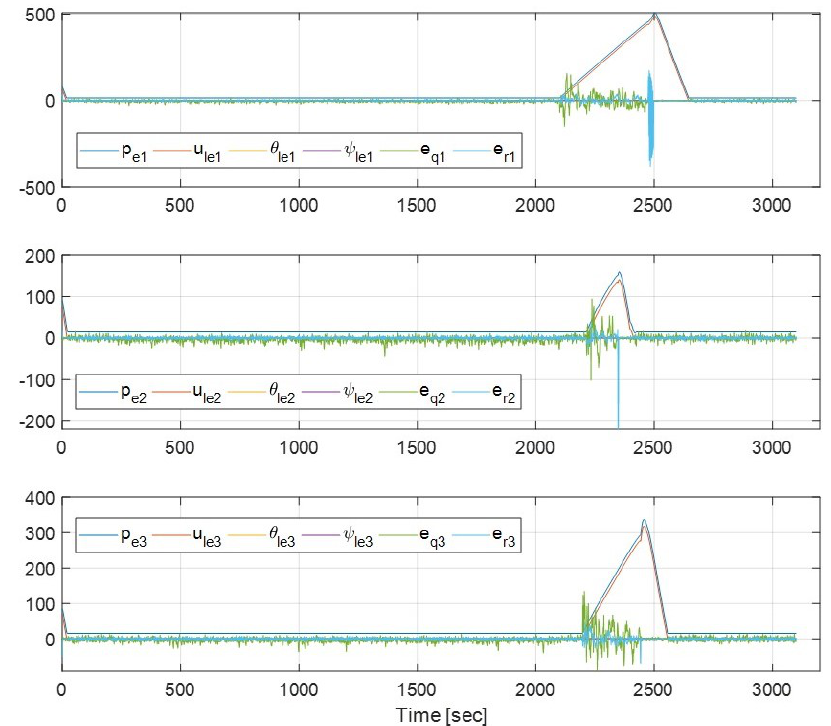
Figure 6. UUB stability of proposed formation scheme in terms of spherical coordinate frame.